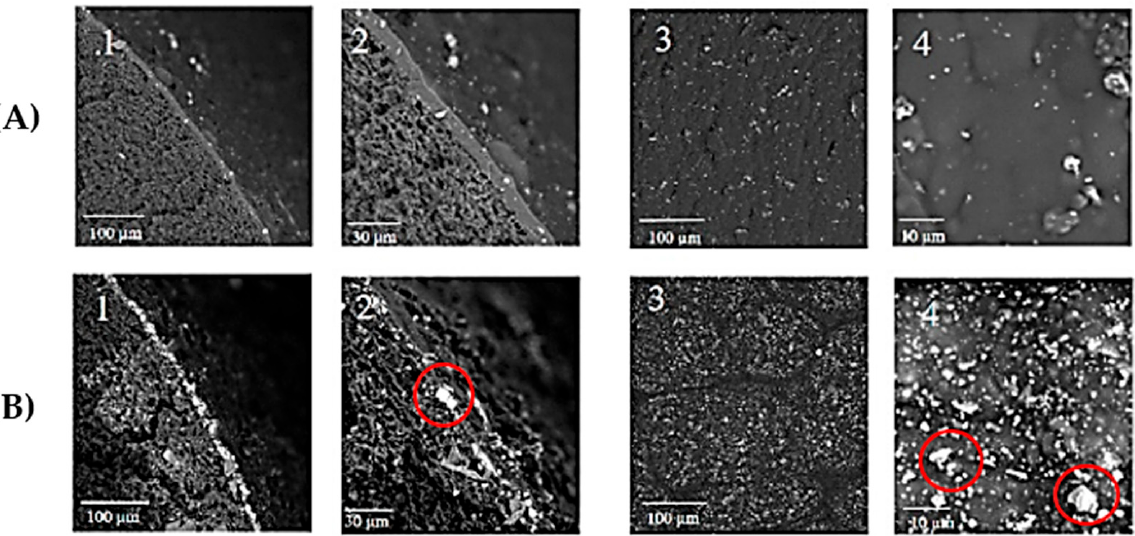
Figure 10. SEM images of cross-section (1 and 2) and outer surface (3 and 4) of PEBAX ® 2533-UiO- 66NH 2 /PP thin film HFMMM-( A ) 20 wt% NH 2 -UiO-66, and ( B ) 50 wt% NH 2 -UiO-66 [73].